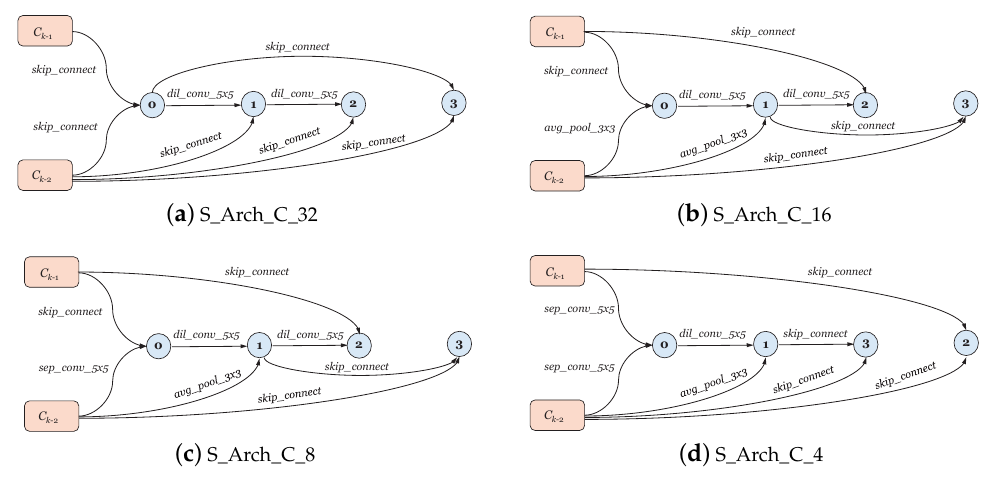
Figure A6. Cell structures obtained over SSDD with ops _ ratio =